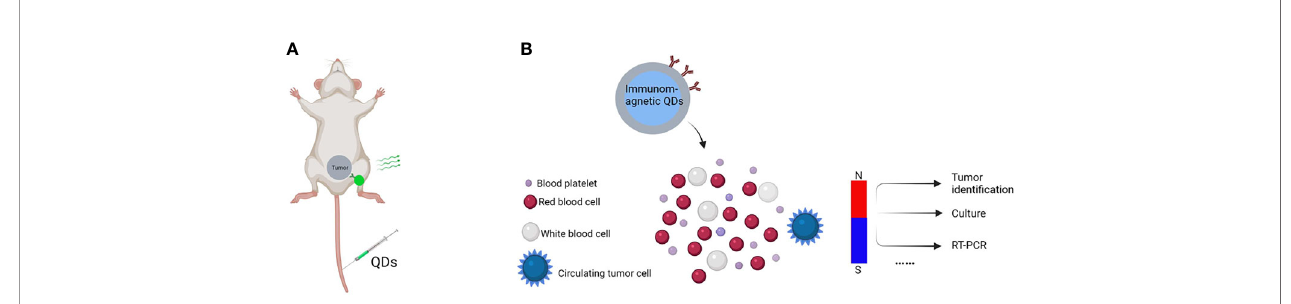
FIGURE 4 | In vivo tumor imaging and CTCs detection. Schematic of in vivo tumor imaging and CTCs detection, (A) QDs-antibody conjugates were injected through the tail vein that distributed ef fi ciently and uniformly in the tumor due to speci fi c binding between cancer cell surface antigen and QDs-antibody conjugates, (B) QDs-antibody conjugates with fl uorescent and magnetic properties are used to detect CTCs in the bloodstreams of animals with no disruption to their function.